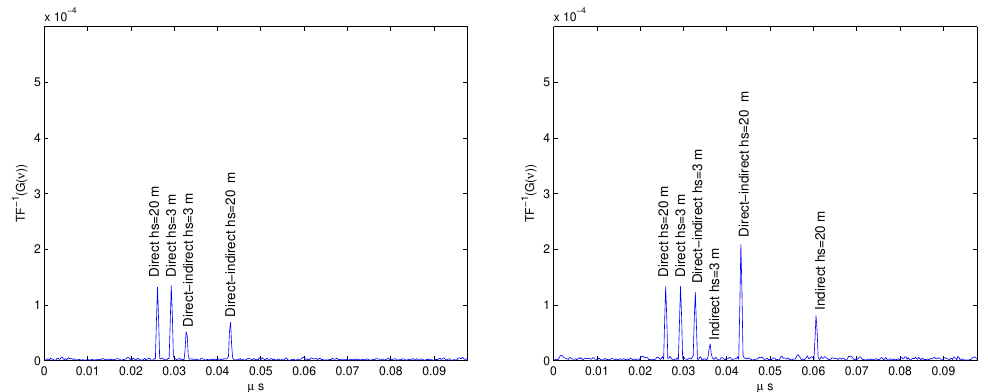
Figure 11. Examples of Inverse Fourier transform of G ( ν ) for two point scatterers (VV a, HH b) h S = 3 m and h S = 20